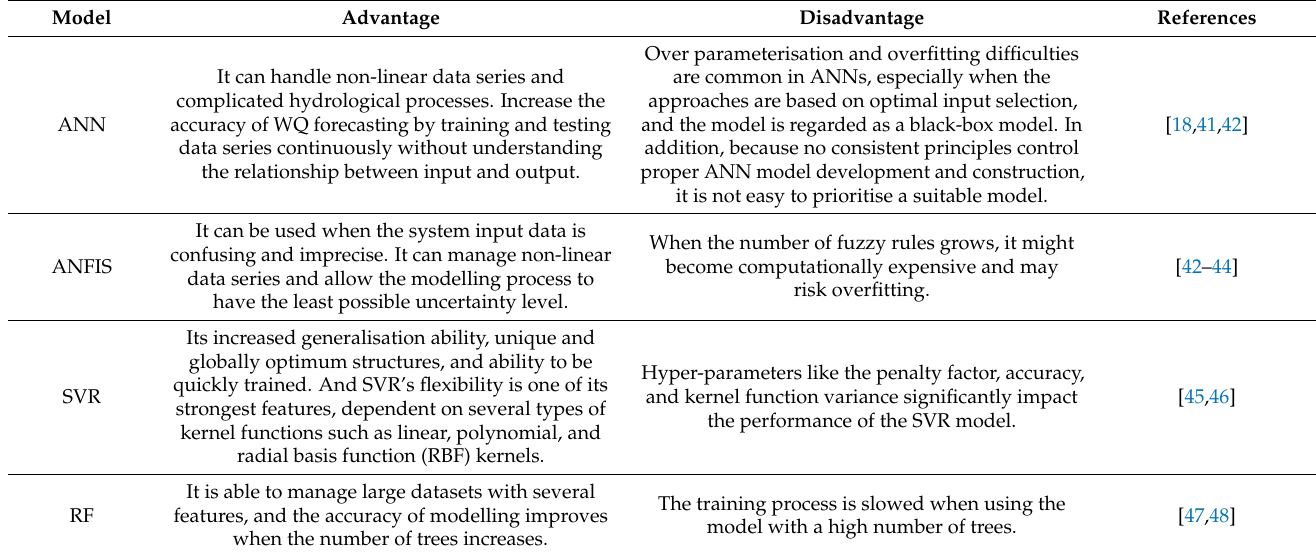
Table 2. Advantages and disadvantages of the ANN, ANFIS, and SVR models.